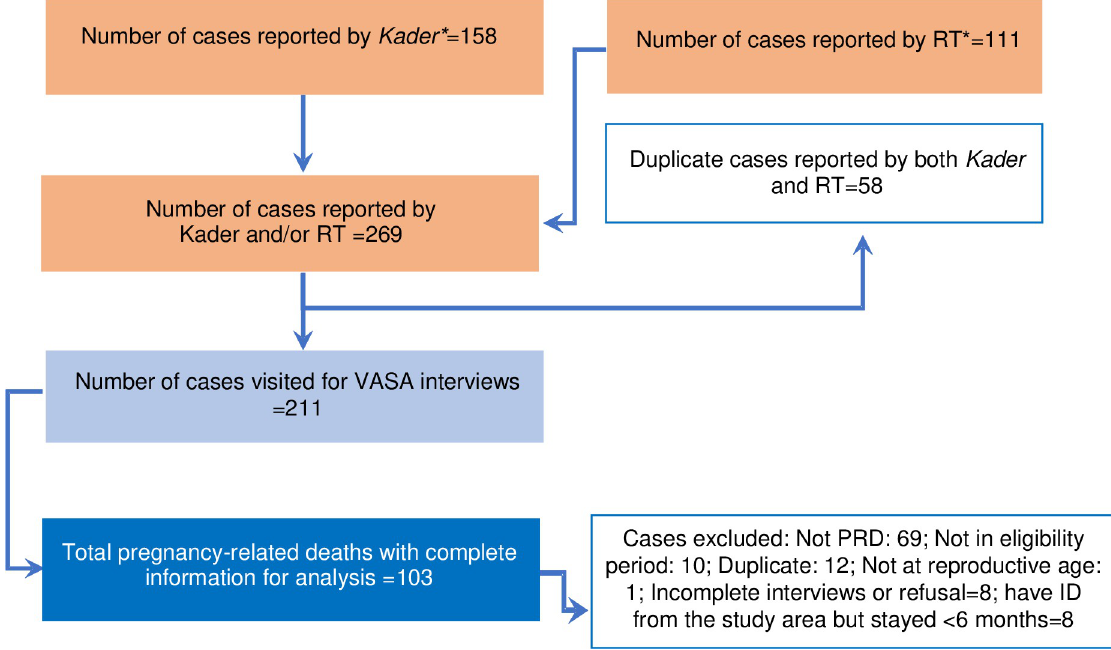
Fig 1. Flowchart of pregnancy-related death (PRD) cases identified in Jember District, 2017–2018. � Kader : community health volunteer; RT : head of a neighbourhood unit. These two groups are generally the most knowledgeable about vital events in the community, as shown from the previous implementation of the MADE-IN/MADE-FOR methods.